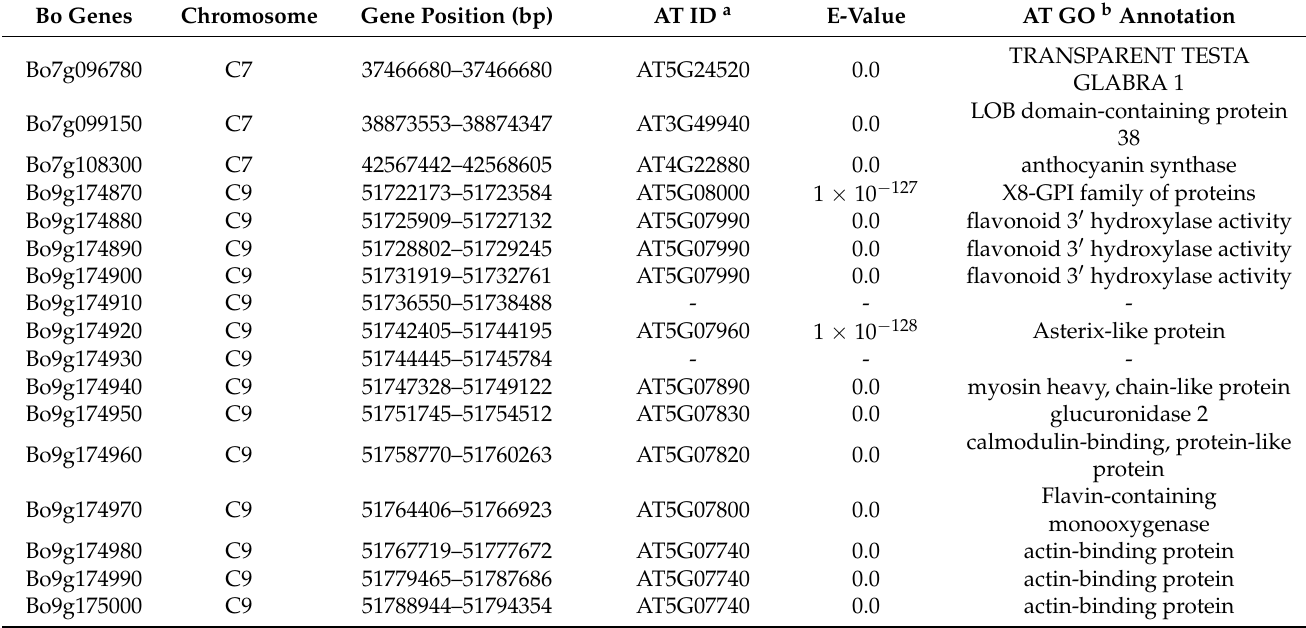
Table 3. Annotation of B. oleracea genes in the candidate